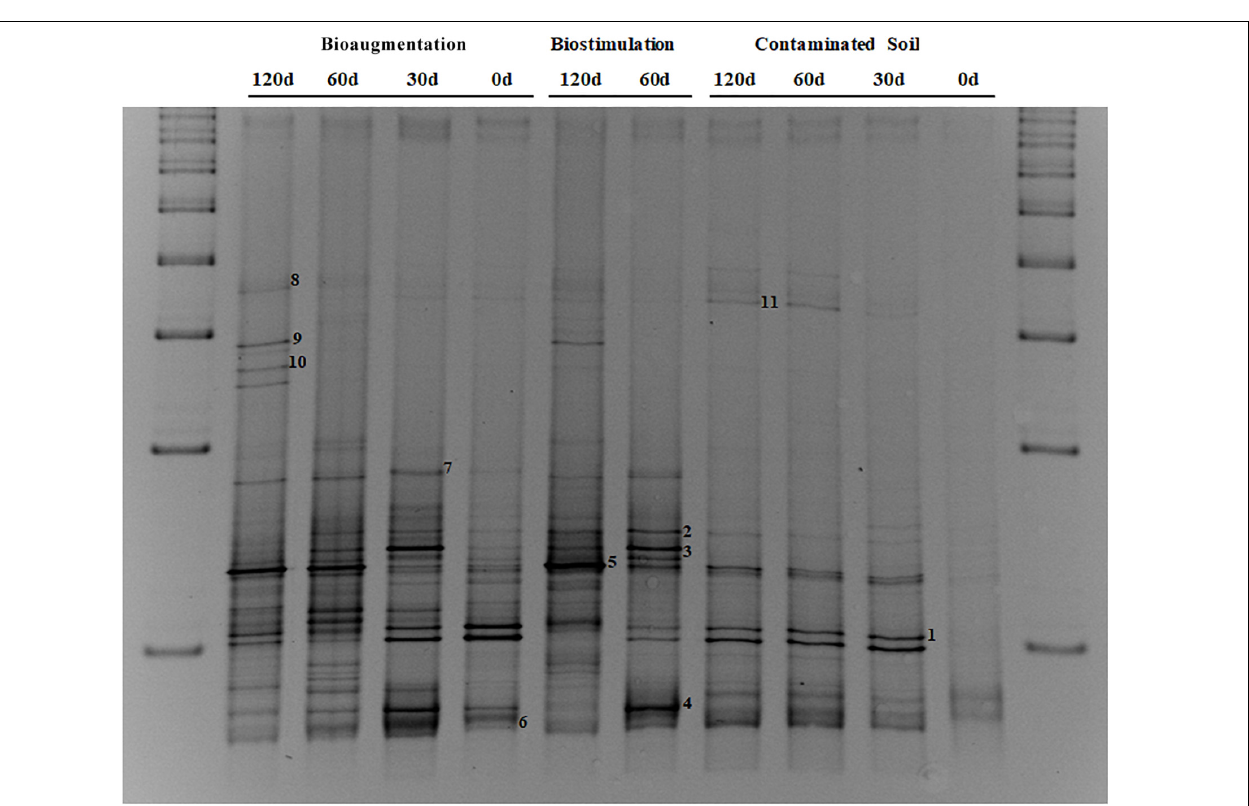
Frontiers in Microbiology |